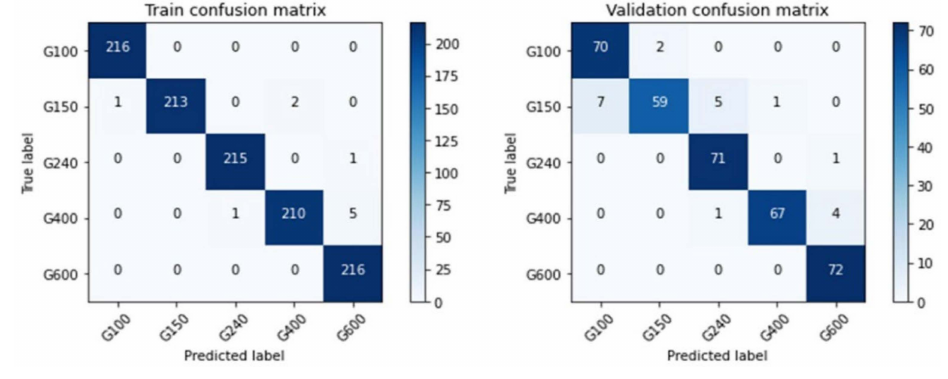
Figure 14. The confusion matrices of the model of the first